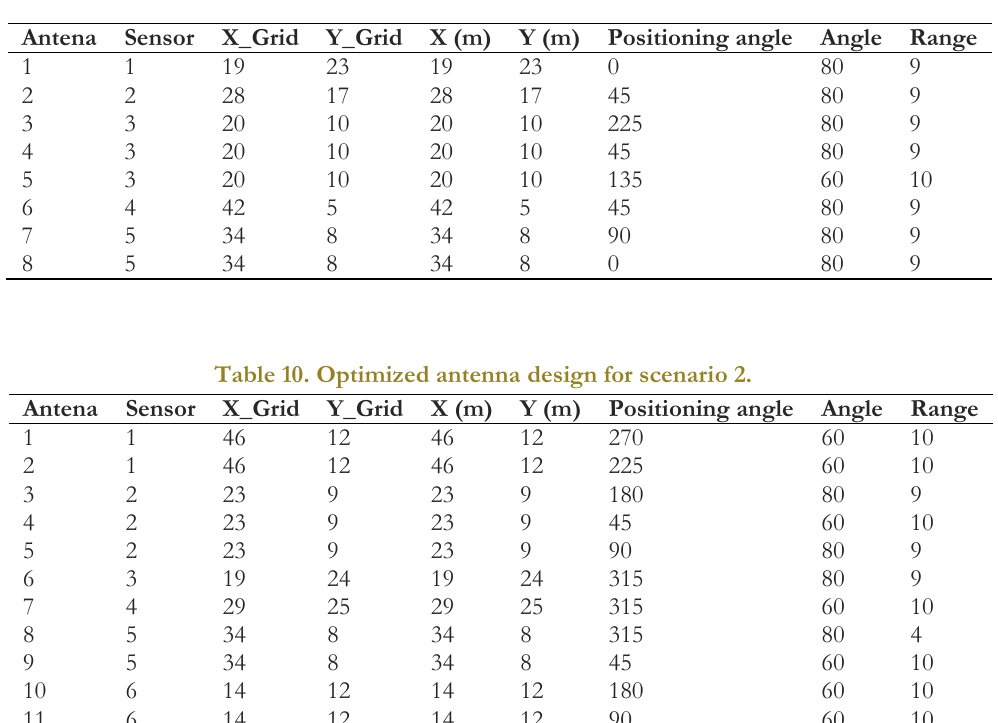
Fig. 16. Results of the GA-SA algorithm for scenario 3: coverage=90%, cost=25 ×1000$. Details of readers and antennas designed for different scenarios can be summarized in Tables 9 to 11 . Table 9. Optimized antenna design for scenario 1.